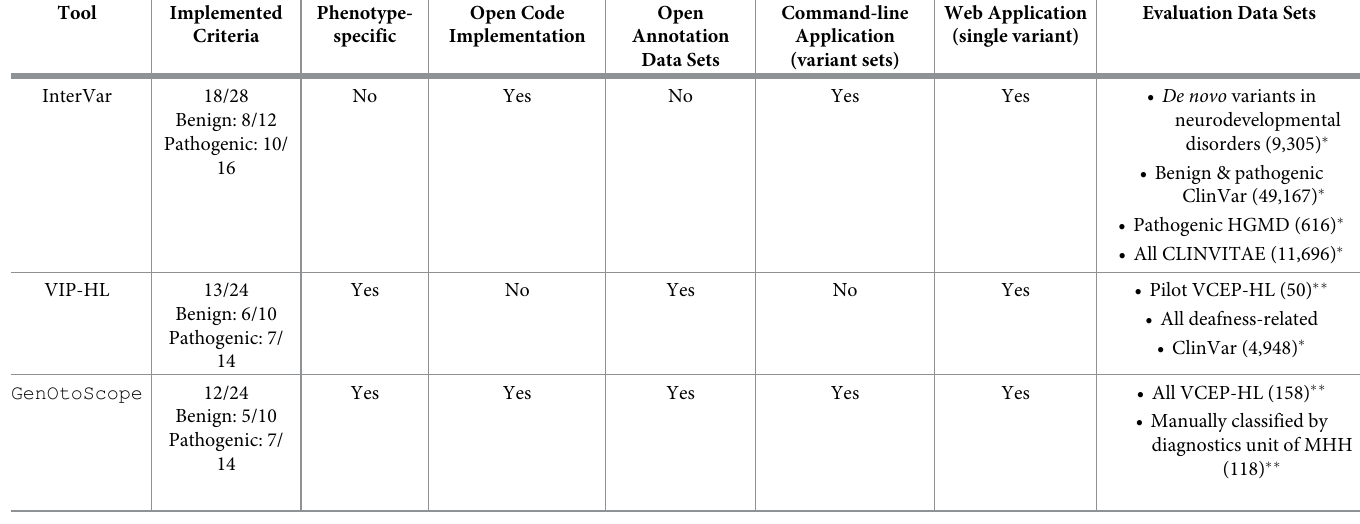
Table 1. Overview of ACMG classification tools benchmarked against